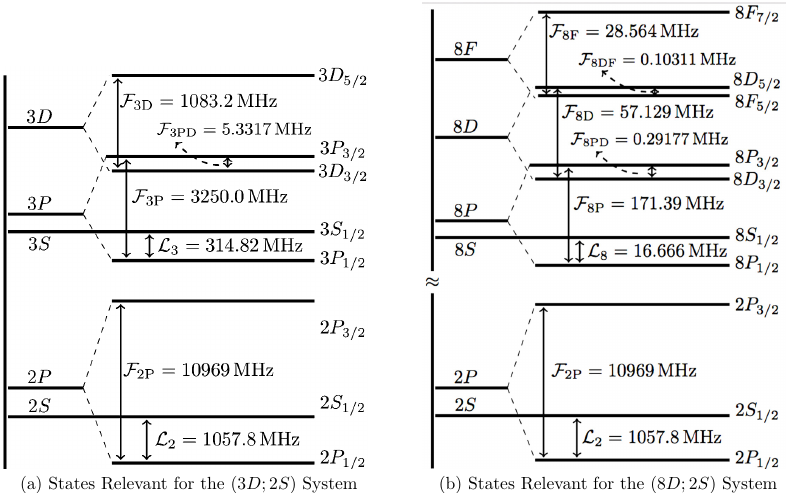
Figure 2. Schematic diagram for energy levels showing the fine structure splittings for n = 2 and n = 3 levels ( a ) and n = 2 and n = 8 levels ( b ). The spacing between the energy levels are not scaled; some closely spaced splittings are exaggerated in comparison with the widely spaced ones for better visibility. In ( b ), instead of displaying all the energy levels for n = 3,4, · · · ,7, we introduced a break in the vertical axis. The nD 3/2 – nD 5/2 and nP 1/2 – nP 3/2 splittings are denoted as F n D and F n P , respectively, while nP 3/2 – nD 3/2 splittings are denoted as F n PD